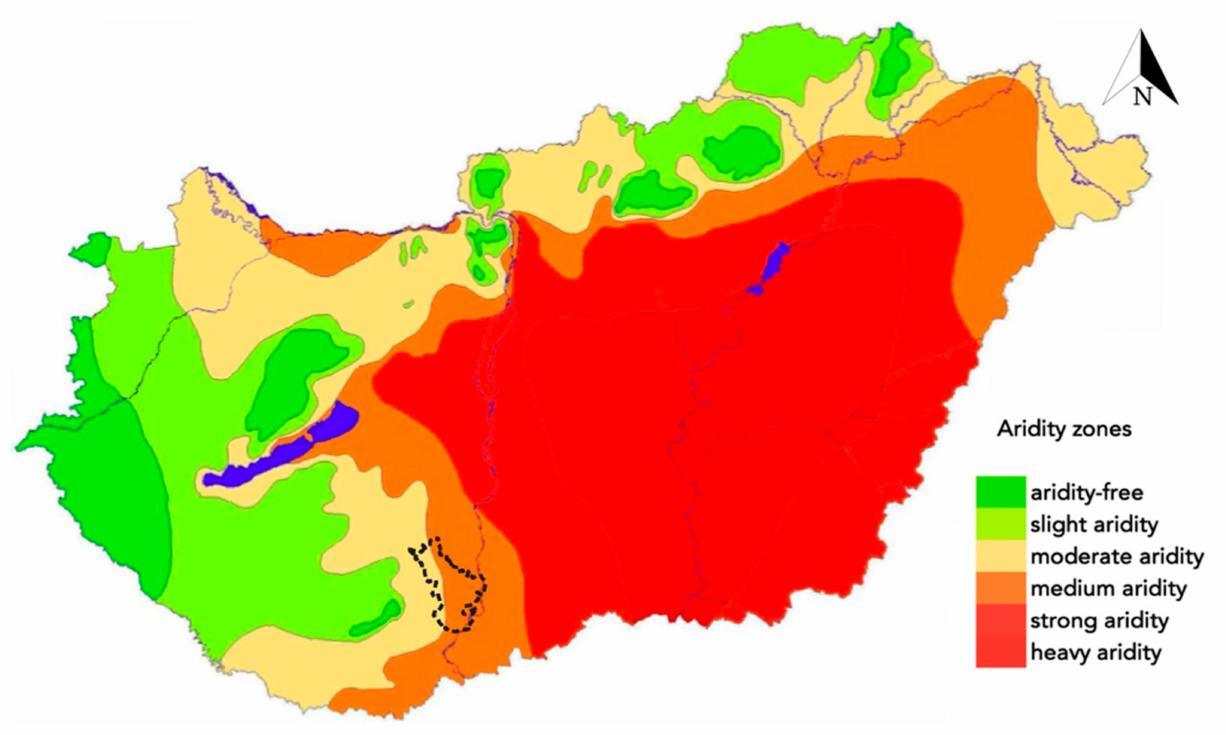
Figure 3. P á lfai’s drought index for the period